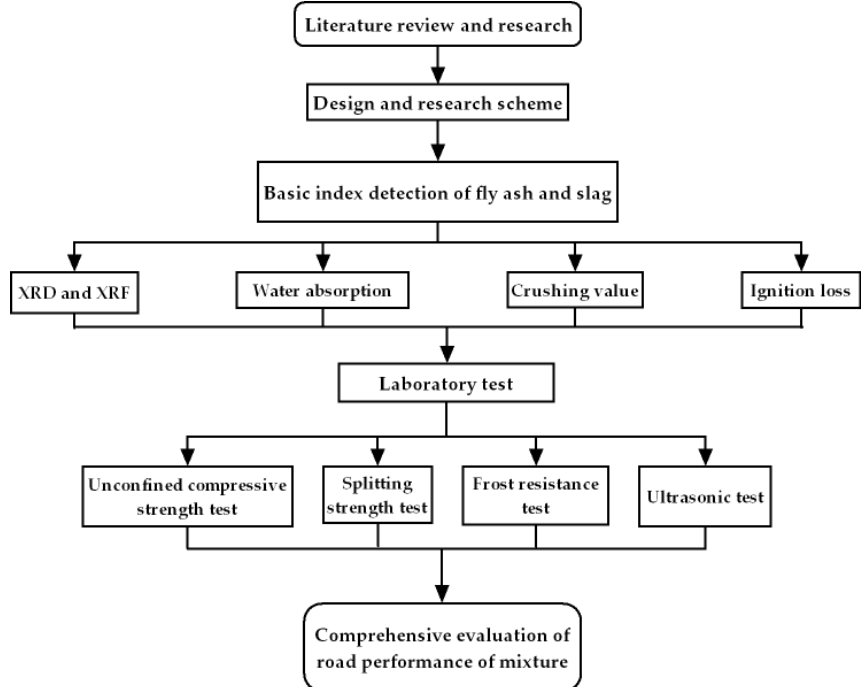
Figure 1. Flowchart diagram of our study.